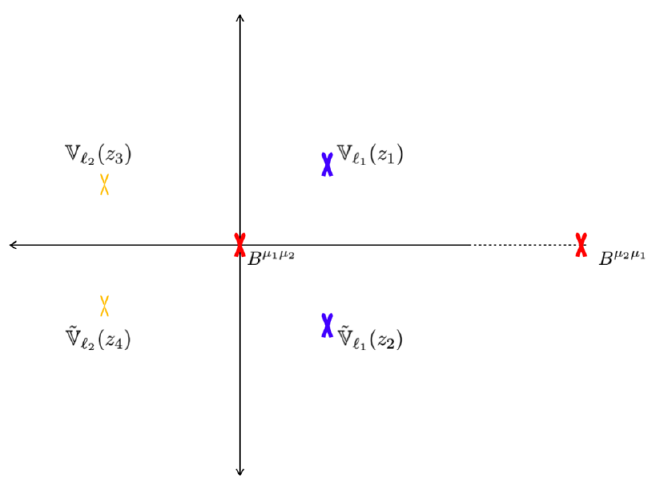
Figure 5. The con(cid:12)guration of various insertions on the two-dimensional complex plane that evaluates the bilocal two-point functions with ZZ and FZZT boundary conditions. Operators B are those that impose the ZZ and FZZT boundary conditions on positive and negative real axis respectively. While the tilde-operators are the mirror operators after the doubling